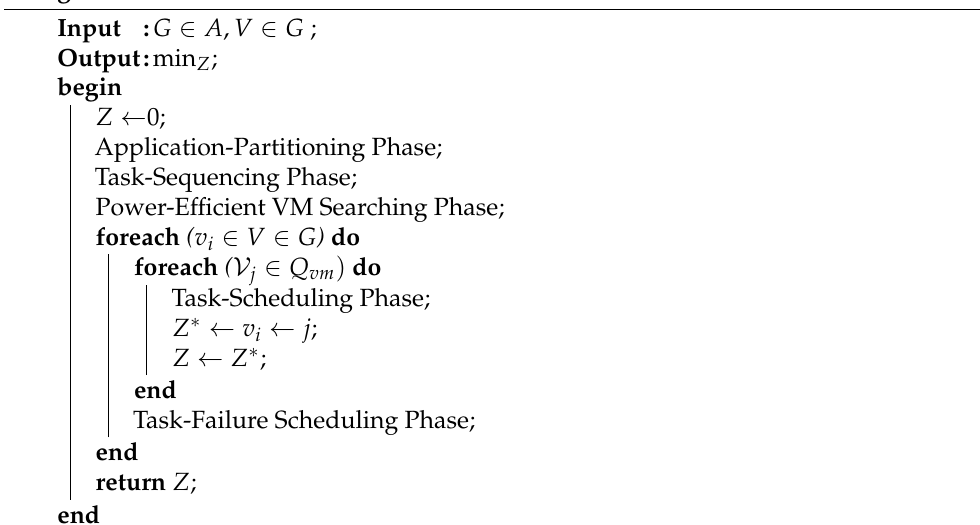
Algorithm 1: DAPWTS